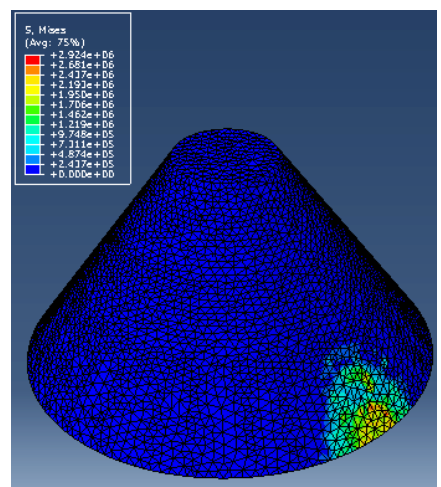
Fig. 7. Von misses composite stress contour in the frustum building while explosion strikes building at height of 6 meters above the